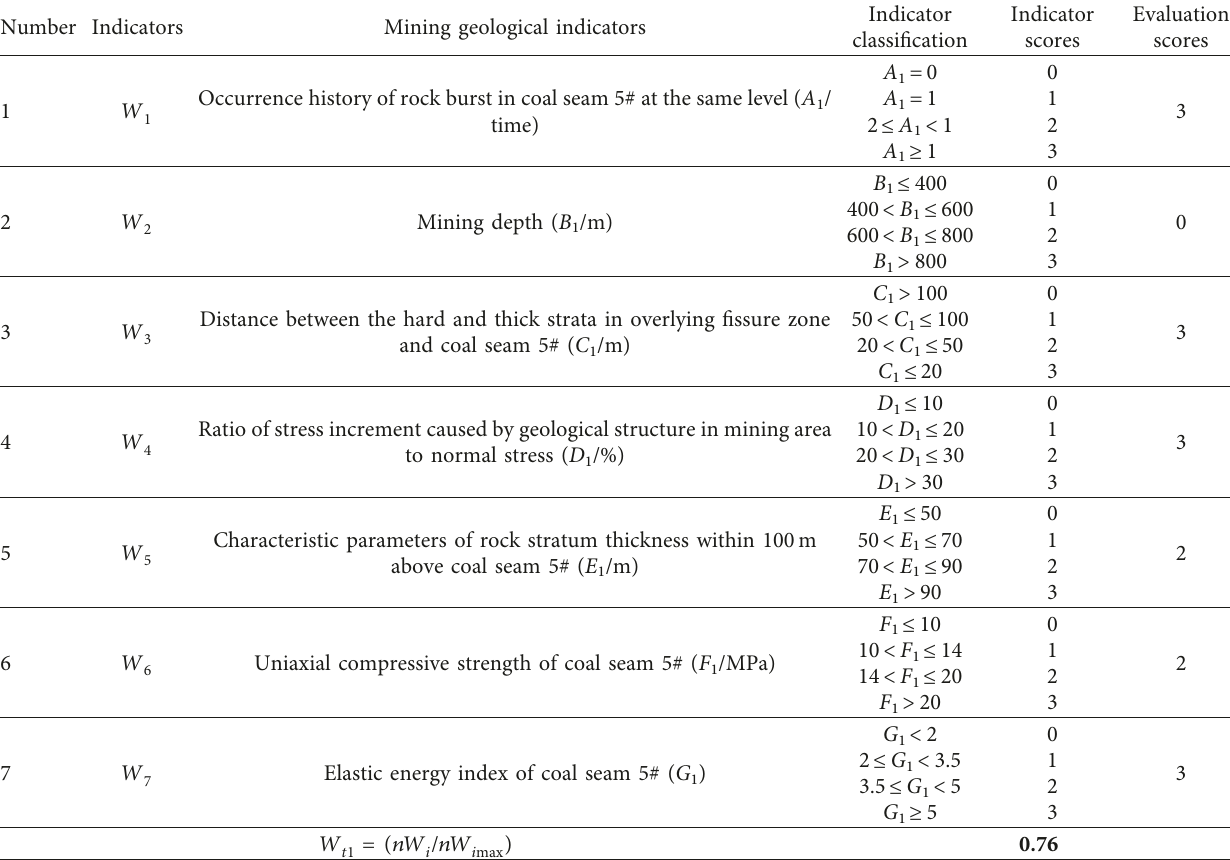
Table 1: The evaluation result of mining geological